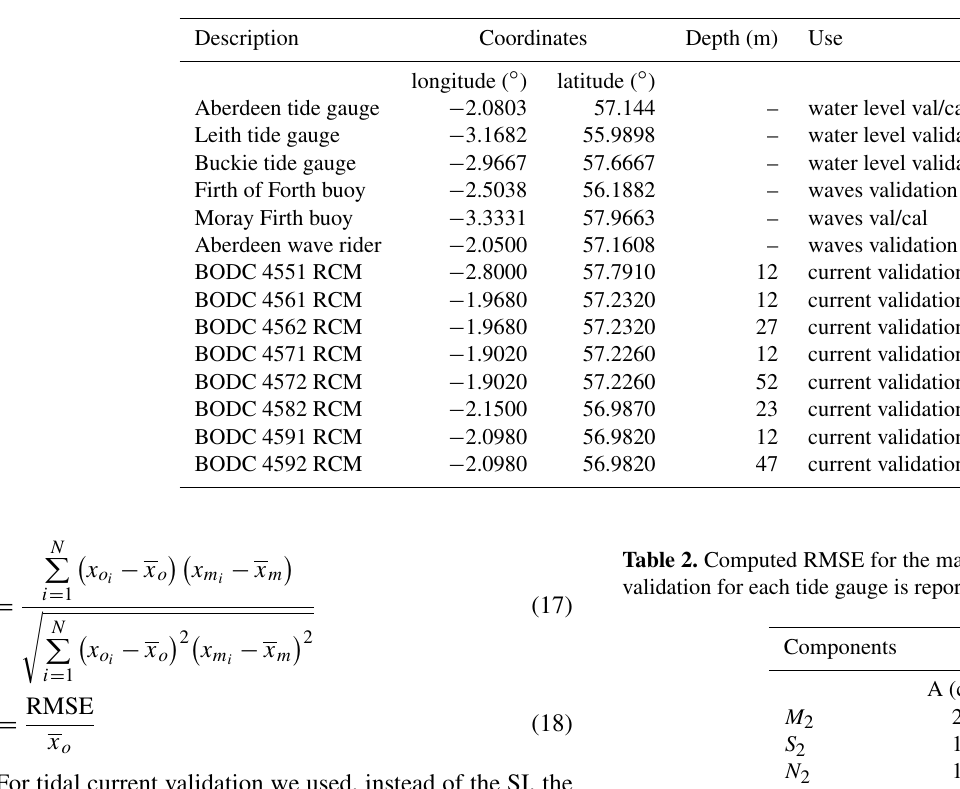
Table 1. Location of the validation/calibration instrumentation.